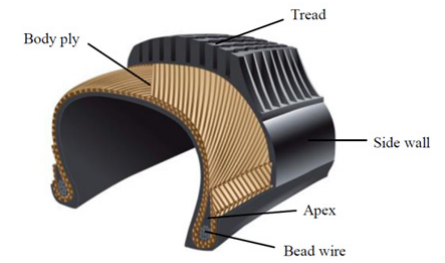
Fig. 2 Section sketch of a bias-ply tyre (Figure courtesy of